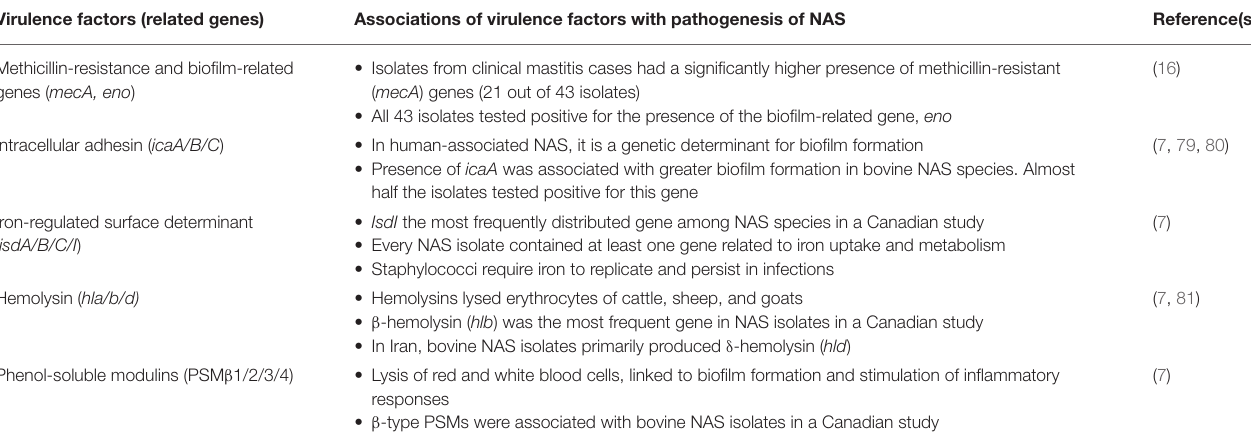
TABLE 3 | Summary of virulence factors and their related genes that were detected in several NAS species, as well as the relationship between these genes and pathogenesis in the context of NAS